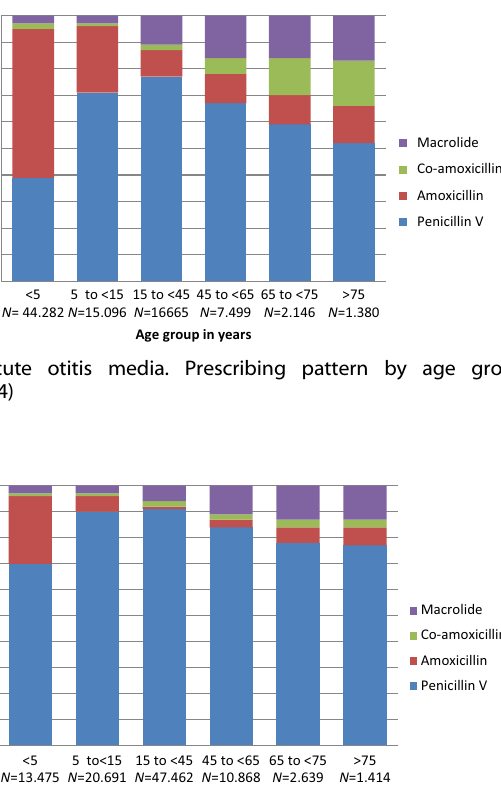
<5 5 to<15 15 to <45 45 to <65 65 to <75 N =13.475 N =20.691 N =47.462 N =10.868 N =2.639 Fig. 3 Acute tonsillitis. Prescribing pattern by age group ( N = 95.459)